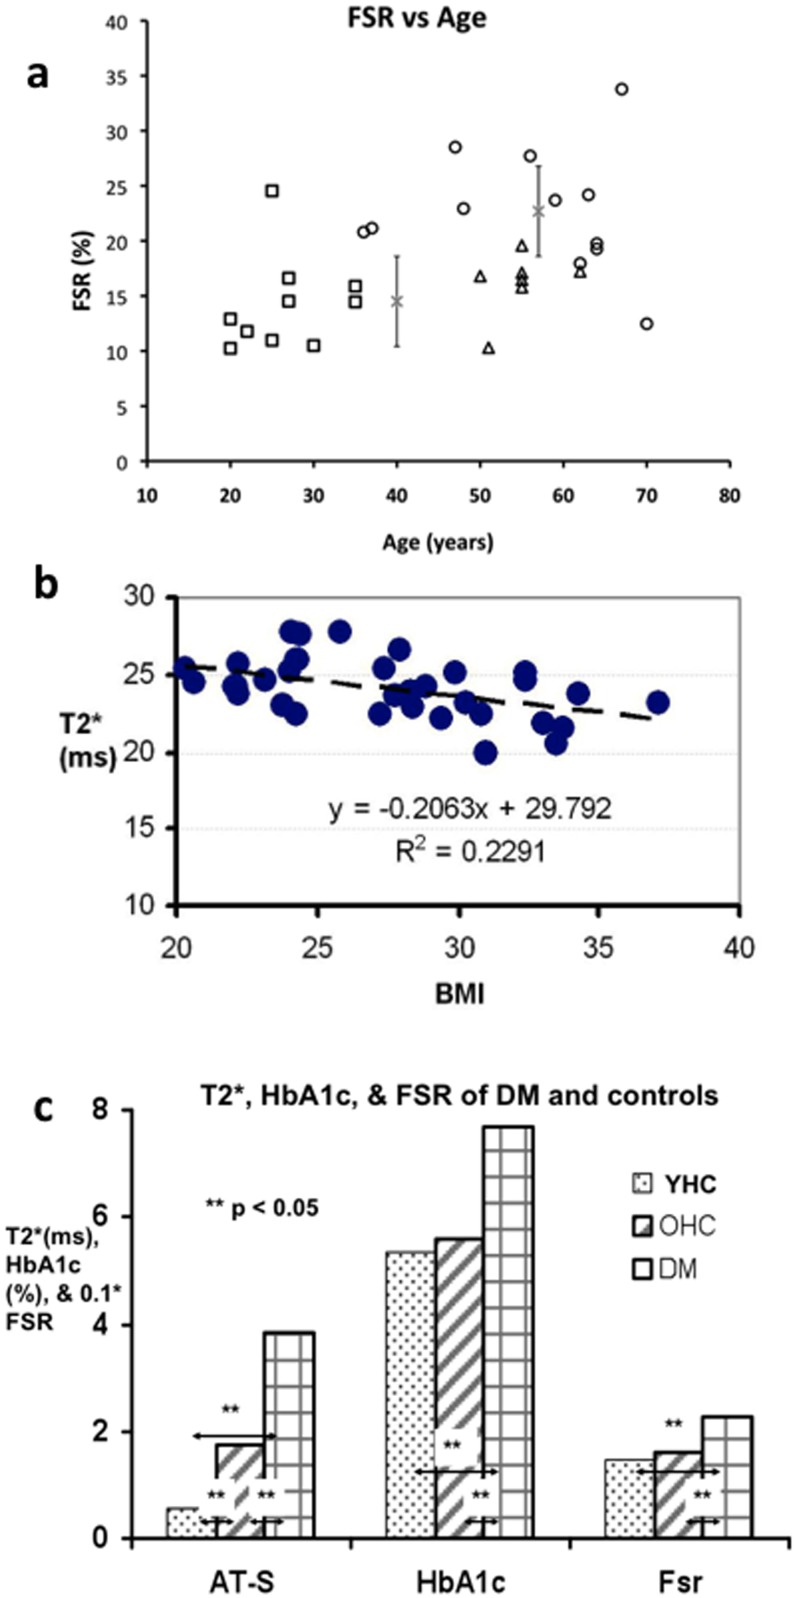
a Plot of FSR versus age for young (squares) and old (triangles) healthy controls as well as T2DM subjects (circles); x's represent the group averages of the DM and the healthy controls (both young and old) and the bars represent standard deviations. b Plot of soleus T2* versus BMI for healthy and T2DM subjects. c Bar plot of soleus T2* change versus anterior tibilias, HbA1c, and lipid index (FRS) for the young and older healthy controls (YHC and OHC) and T2DM (DM) subjects scanned in this study.